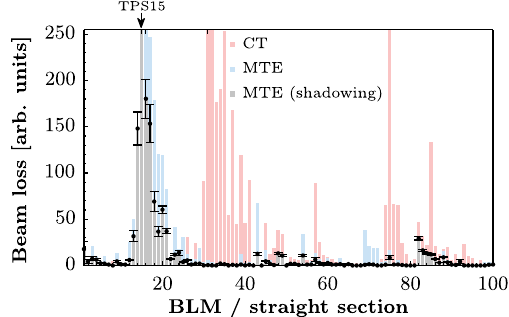
FIG. 25. Integrated beam loss measured after extraction on the MTE cycle using TPS15 and SMH16 in shadowing configura- tion. Only BLM15 is saturated, and beam loss at the adjacent SMH16 is significantly reduced. For comparison, the MTE case without TPS15 and the CT case are shown. Error bars for the case of MTE with shadowing correspond to the standard deviation of 500 consecutive measurements.